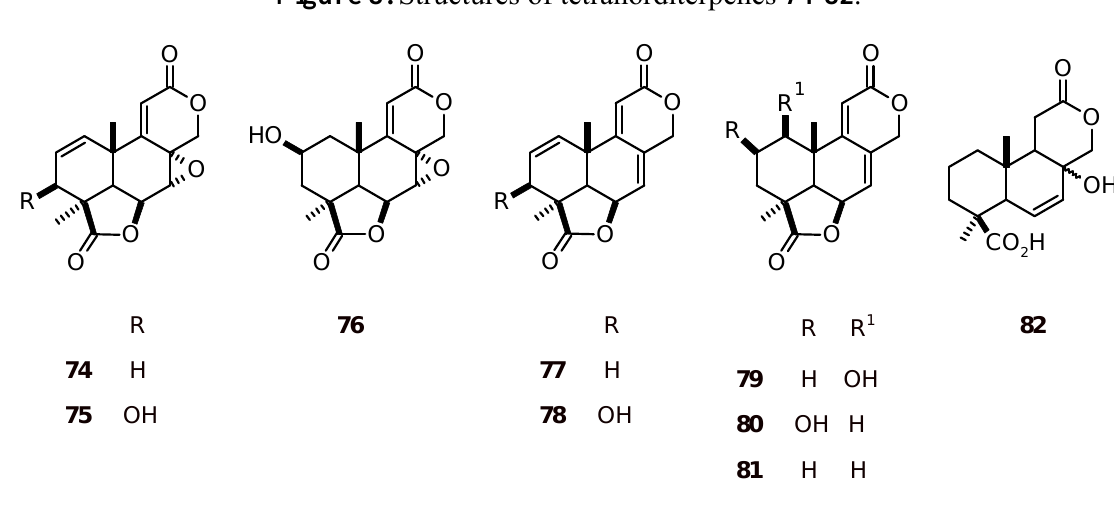
Figure 8. Structures of tetranorditerpenes 74 - 82 .